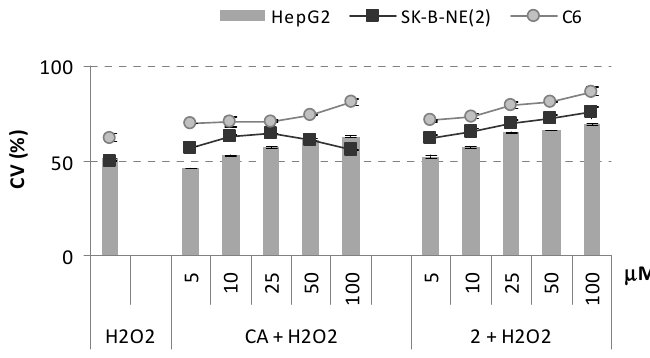
Figure 6. Cytoprotective effects of CA, and PNA-CA dimer 2 against H induced oxidative stress on HepG2, SK-B-NE(2), and C6 cell lines. Values of Cell Viability (CV, %), reported as percentage vs . an untreated control, are the mean value ± SD of measurements carried out on 3 samples (n = 3) analyzed twelve